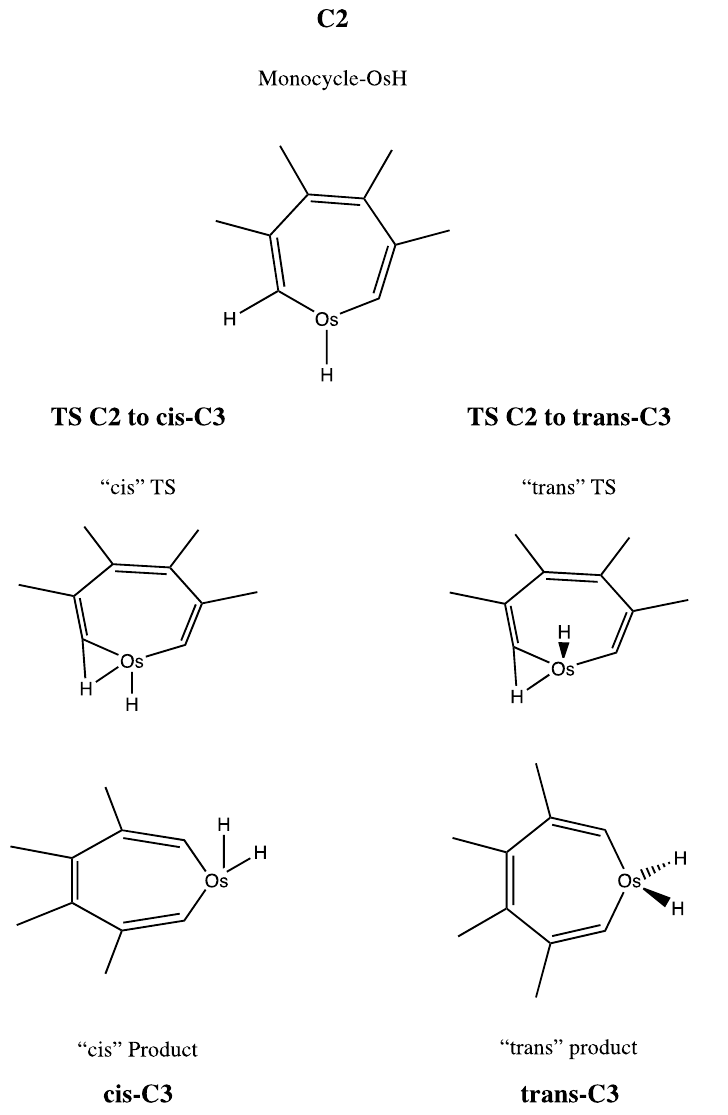
Figure 9. Landmarks for the second proton transfer to Os for the cyclic scaffold (the Cyclic Path C, steps C2 to C3 ) which may branch to “ cis ” and “ trans ” pathways, to cis-H 2 OsC 6 H 4 or trans- (the Cyclic Path C, steps C1 to C2 H 2 OsC 6 H 4.